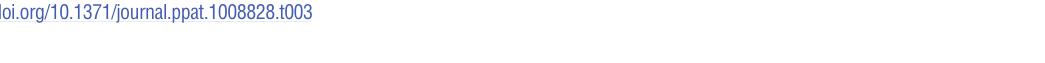
a CHO cell mutant, heparan sulphate deficient (HS - ) cell line. b CHO cell mutant, heparan sulphate deficient (HS - ) and chondroitin sulphate deficient (CS - ) cell line. c CHO cell mutant, sialic acid deficient (SA - ) cell line. N indicates no